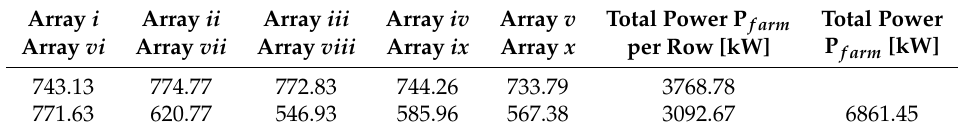
Table 5. Power output in kW for the 50 OSWEC farm for an irregular wave of H m 0 = 2.55 m and